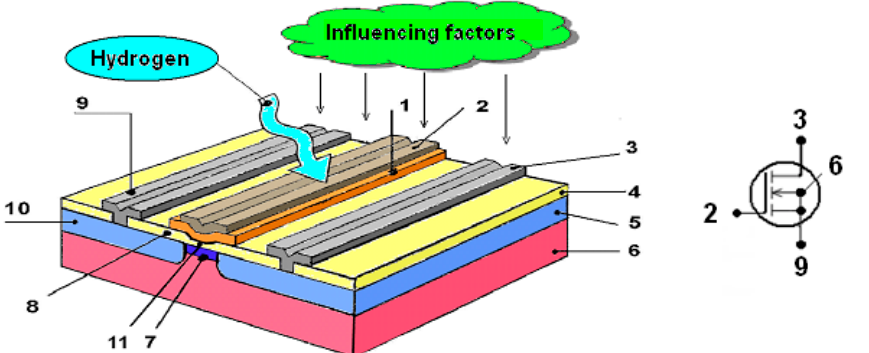
Figure 1. The structure and the schematic designation of TSE: 1 is gas-sensitive film, 2 is metal gate, 3 and 9 are drain and source contacts, 4 and 8 are passivating films, 5 and 10 are drain and source, 6 is substrate, 7 is channel, 11 is thin gate dielectric.